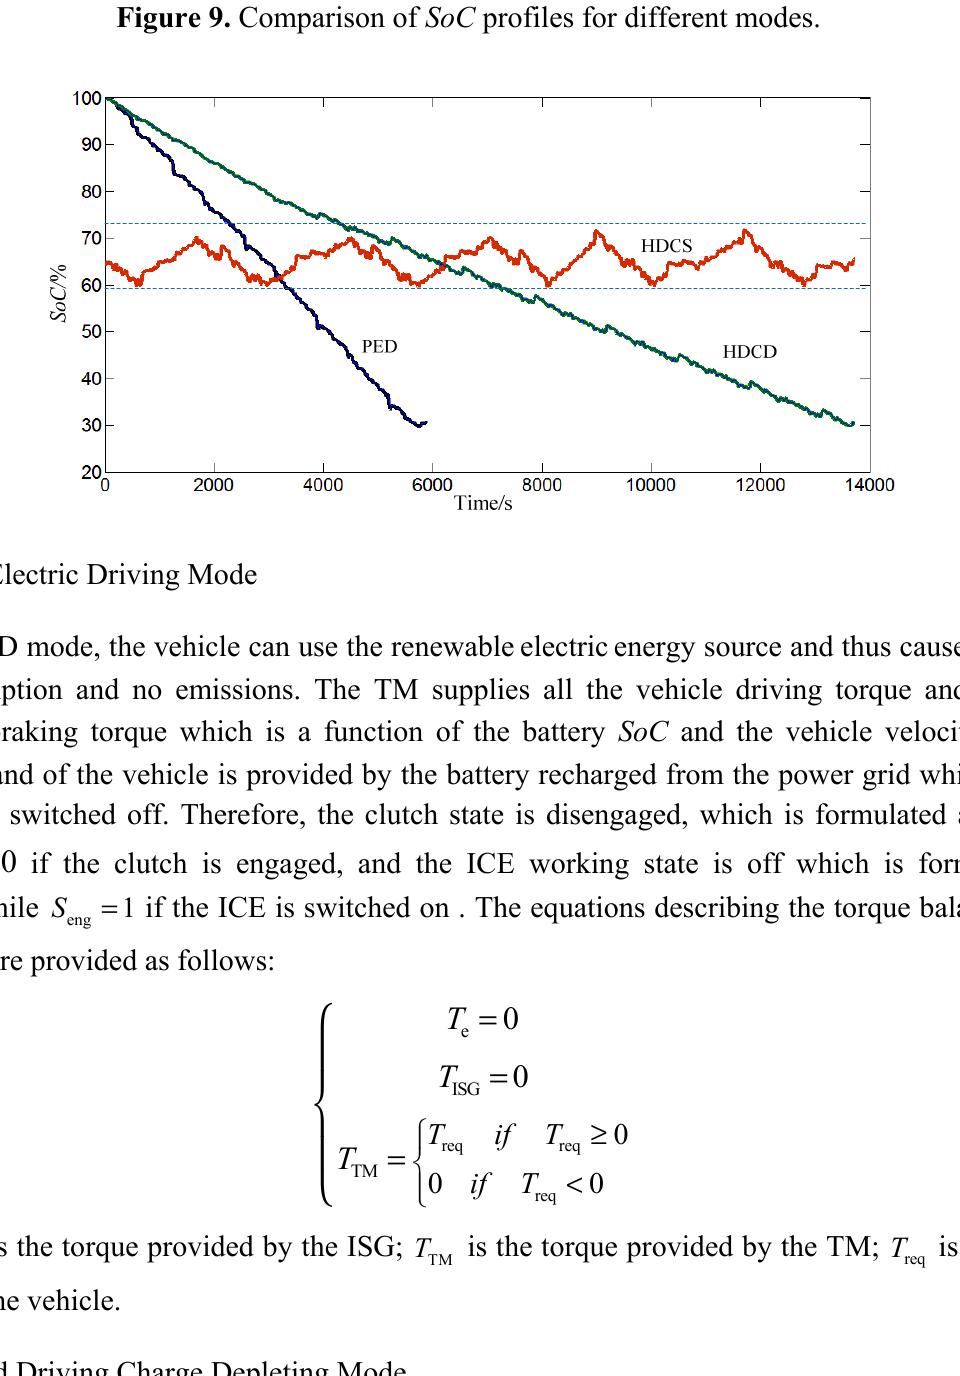
Figure 9. Comparison of SoC profiles for different